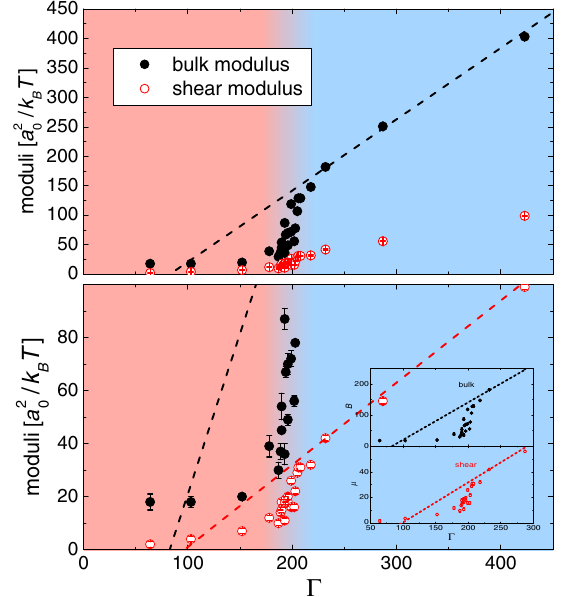
FIG. 4. Temperature-dependent bulk and shear moduli. The data suggest a jump of moduli at the transition temperature, which is located at Γ T ¼ 195 (cid:4) 5 . The lower plot zooms in on the ordinate. In the solid, the moduli grow linearly due to increased pressure indicated by dashed lines, and we extrapolate this linear behavior down to the fluid. The inset shows a zoom of ordinate and abscissa: The data are not compatible with a continuous increase of elasticity as, e.g., given by the dotted lines.